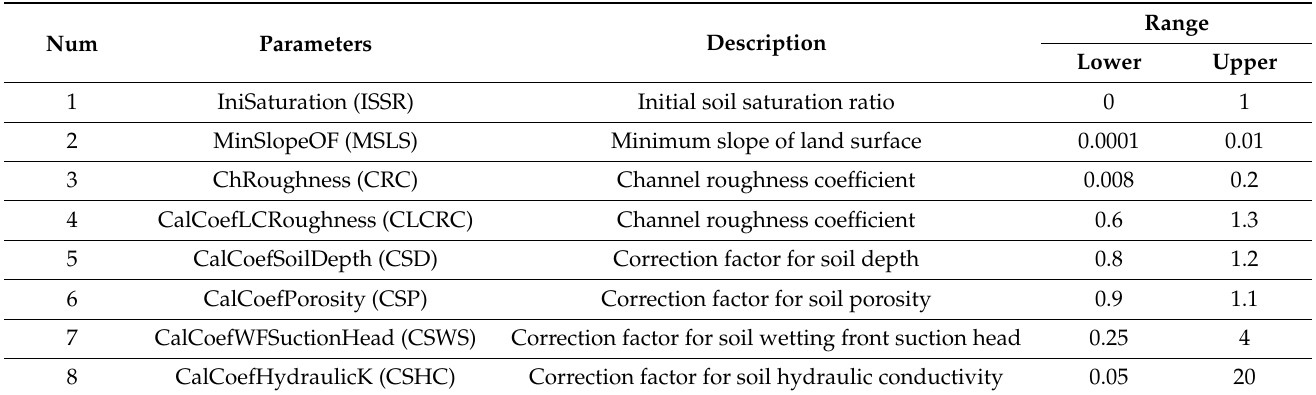
Table 2. Parameters of the GRM